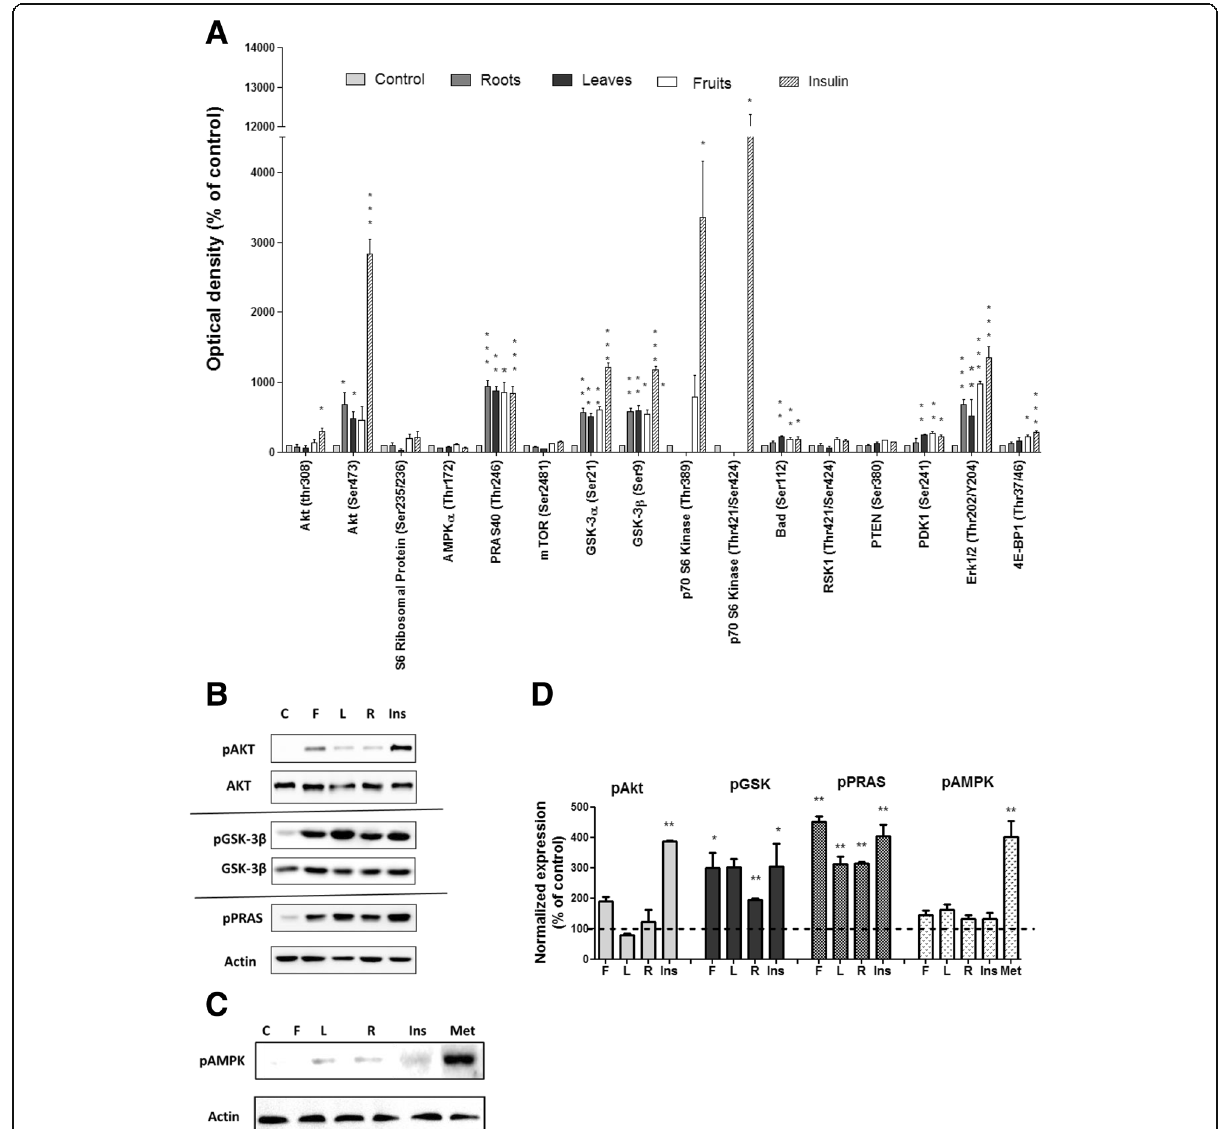
Fig. 6 S. spinosum extracts induced the phosphorylation of Akt downstream protein with only minor phosphorylation of Akt. L6 myotubes were treated with 100 nM insulin or S. spinosum extracts for 20 min. a A simultaneous detection of 16 phosphorylated proteins predominantly belonging to the insulin signaling network was performed on whole cell lysates using PathScan analysis antibody array, as described in Materials and Methods . The results were detected by enhanced chemiluminescence and optical density was measured. Data are expressed as percent of OD obtained in control. The data represents the Mean ± SEM of 4 replicates. b and c L6 myotubes were untreated for negative control (C), or treated with 100 nM insulin (Ins), S. spinosum fruits (F), leaves (L) or roots (R) extracts or metformin (Met) for 20 min. Western-blot analysis of whole lysate was performed using specific antibodies. These are representative results of 3 independent experiments. The bar graph in d is the result of optical density measurements of Western blots in b and c . * p < 0.05, ** p < 0.005, *** p < 0.0005 compared to untreated cells by Student ’ s t